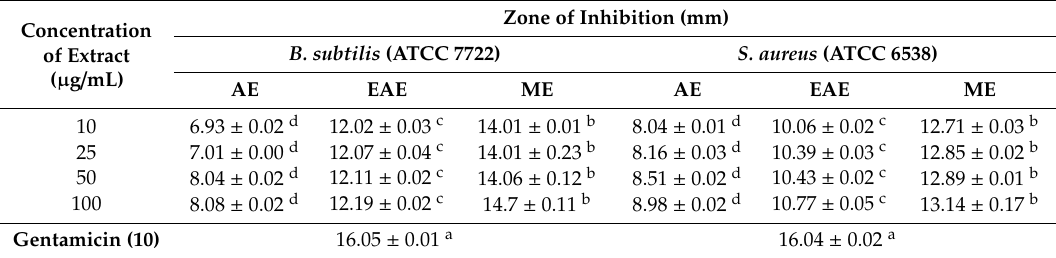
Table 7. Activity of di ff erent M. esculenta leaves extracts against Gram-positive bacteria. Concentration of